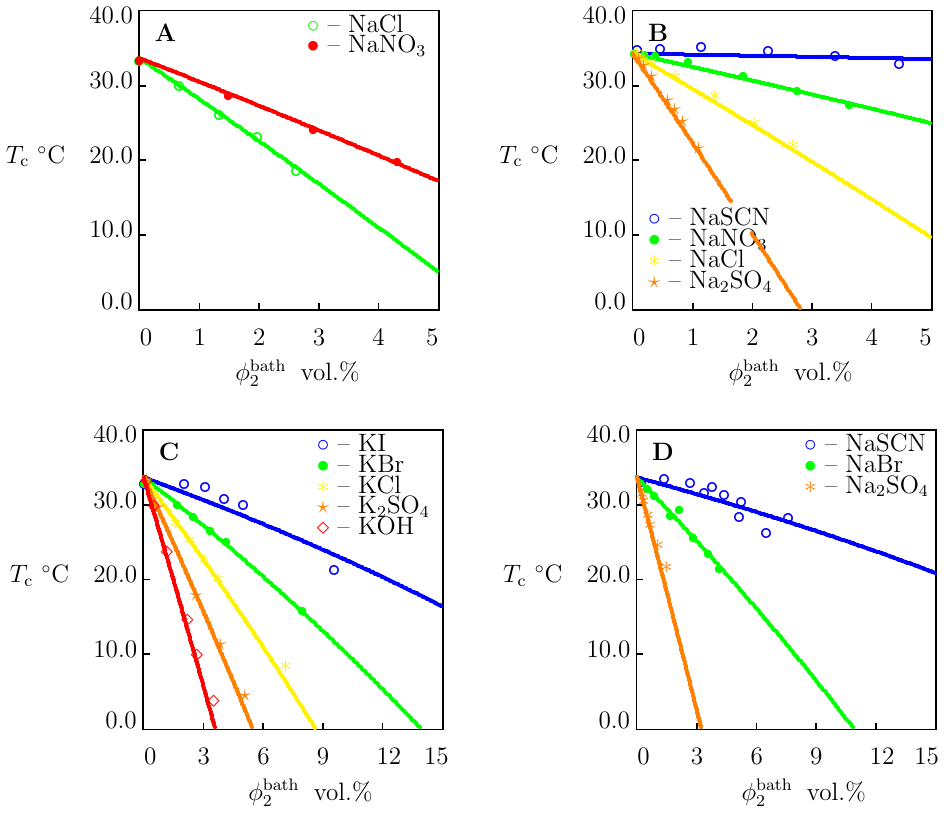
Figure 7. The critical temperature T c versus concentration of salts in aqueous solutions φ bath experimental data on PNIPAm chains in aqueous solutions. ( A )—[43], ( B )—[44], ( C )—[11], ( D )—[45]. Solid lines: results of numerical